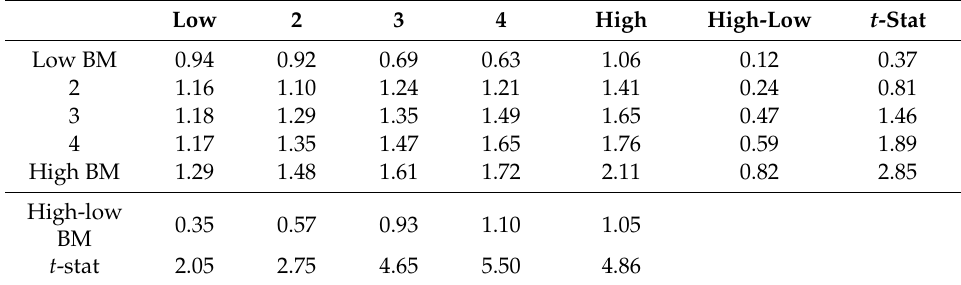
Table 14. Average returns from double-sorted quantile portfolios (sorted by book-to-market ratio and Geske’s short-term default probability). From the data for July 1963 to December 2013, at the end of each month, stocks are independently sorted into 5 × 5 portfolios based on the book-to-market ratio and Geske’s short-term default probability. The table shows average returns for each of 25 portfolios. Small-big is the return di ff erential between the small and big firm portfolios within each default quantile. High-low is the return di ff erential between the high and low default probability firms within each size quantile. t -statistics are calculated using Newey-West standard errors.